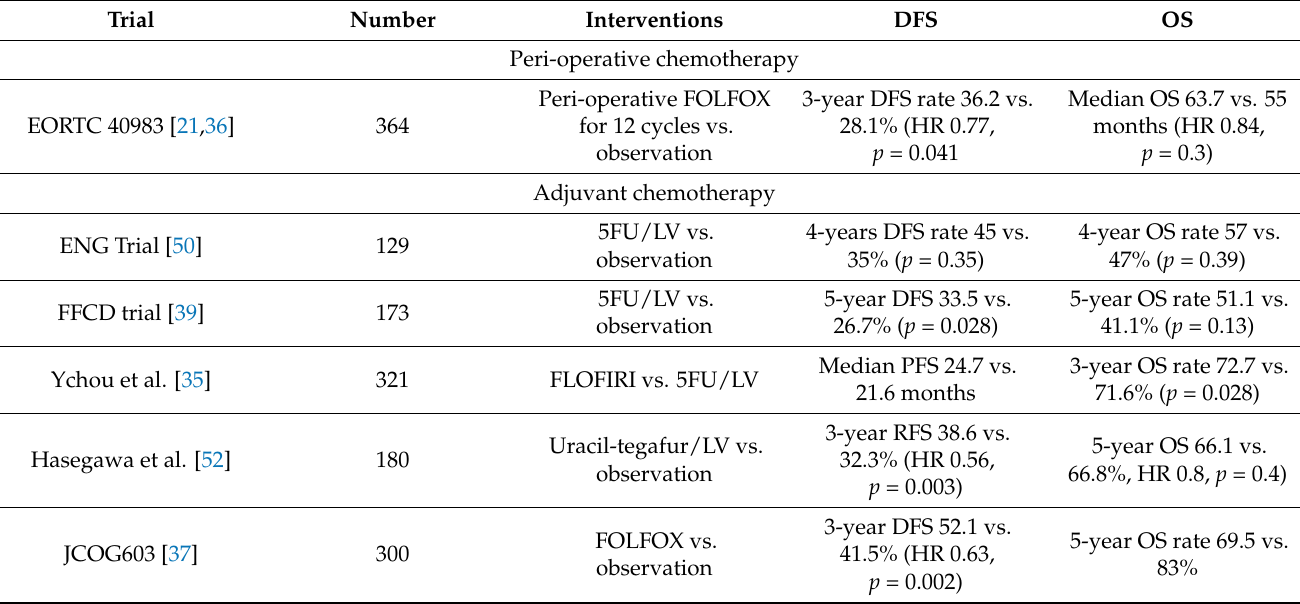
Table 1. Summary of randomized clinical trials that assessed peri-operative or adjuvant chemotherapy in patients with metastatic colon cancer with resectable liver